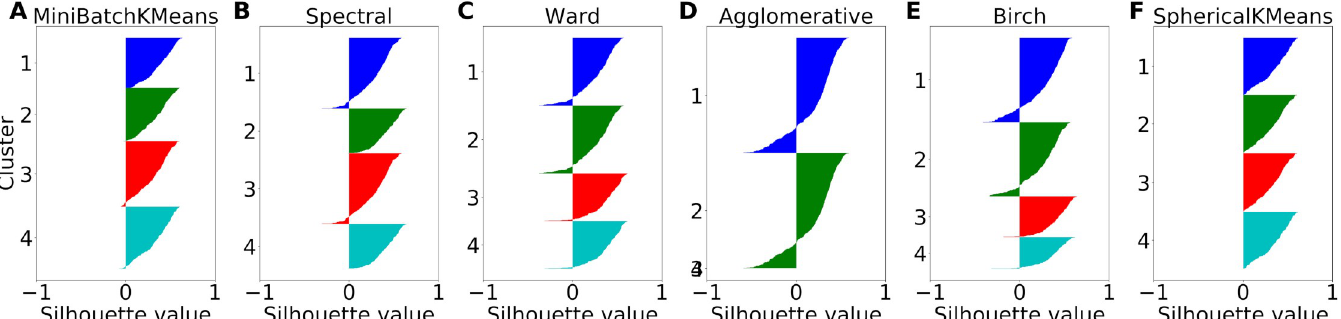
Fig 4. Silhouette comparison of clustering algorithms on synthetic categorical data. Synthetic data consist of firing rates from a total of 400 simulated cells representing the variables chosen value, offer value A, offer value B and chosen juice (100 cells each). Independent Gaussian noise with a standard deviation of 0.25 and a mean given by the variable rates was used to simulate the activity of a cell. Each color corresponds to one cluster. Clustering algorithms were Mini-Batch k-means (A), Spectral Clustering (B), Ward (C), Agglomerative Clustering (D), Birch (E) and Spherical k-means (F).The number of clusters was fixed to 4.